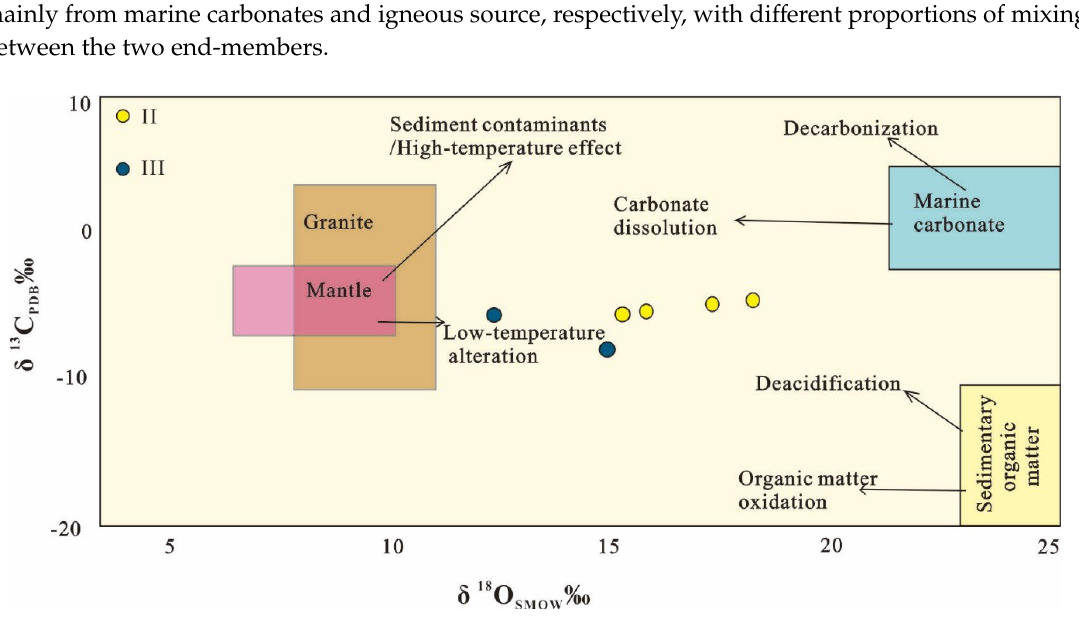
δ 13 C vs. δ 18 O diagram for ore-related calcite from Xianglushan Fe-Cu deposit Figure 9 Figure 9.